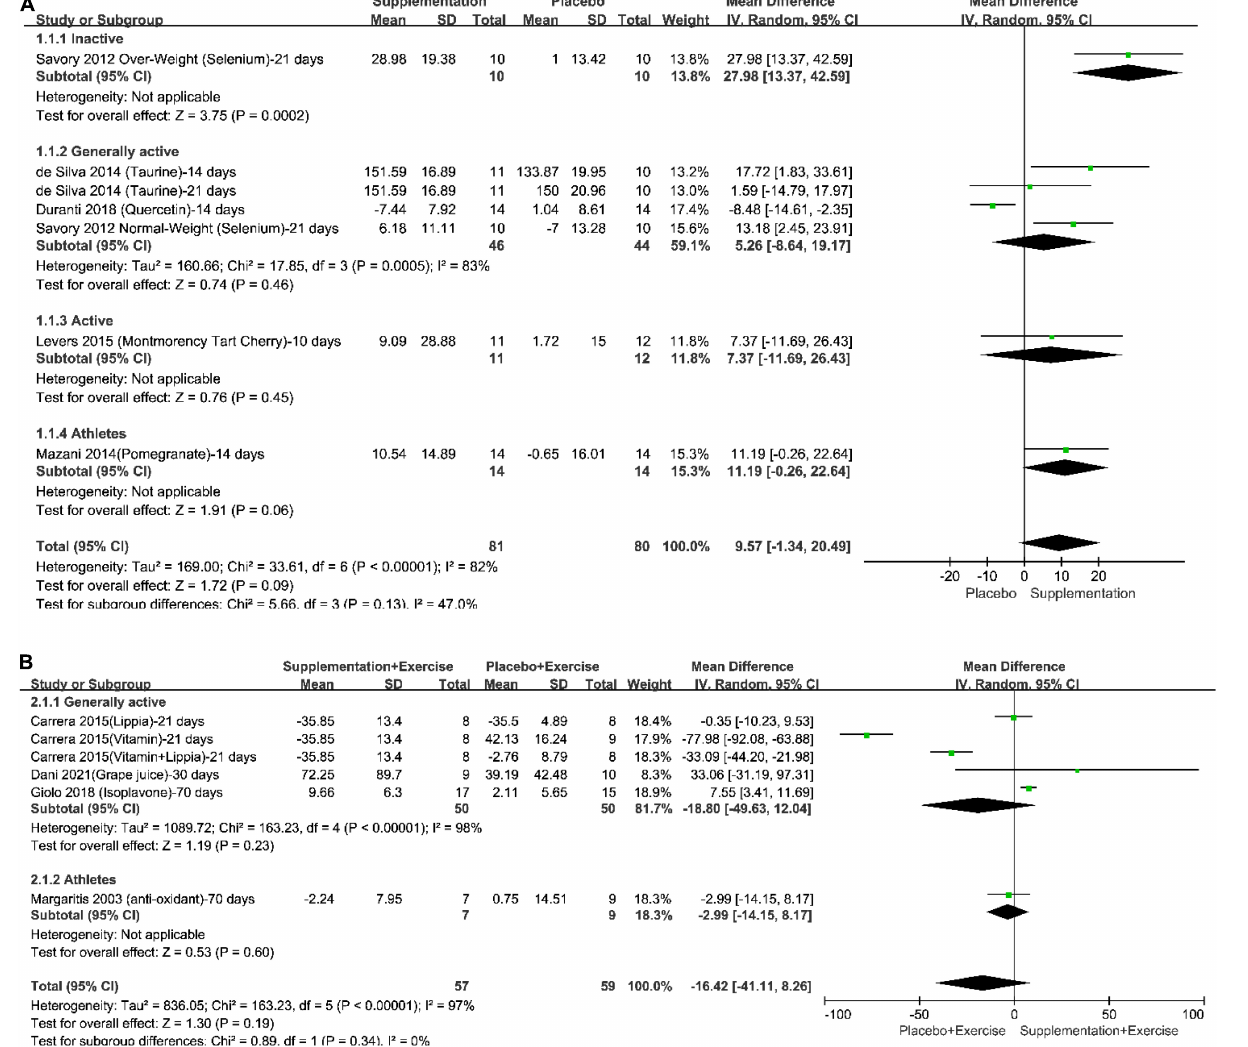
FIGURE 3 | Forest plots of the pooled effect of different supplementation protocols on the increasing plasma superoxide dismutase (SOD) under resting-state. (A) Long-term supplementation vs. Long-term placebo intake; (B) Long-term combination of supplementation and physical exercise vs. Long-term combination of placebo intake and physical